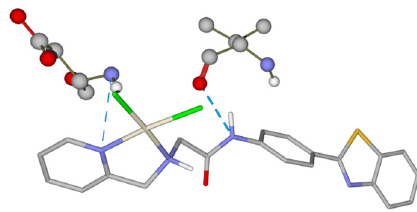
Figure 4. Intermolecular interaction between platinum complex, Val 882 and Asp 884.